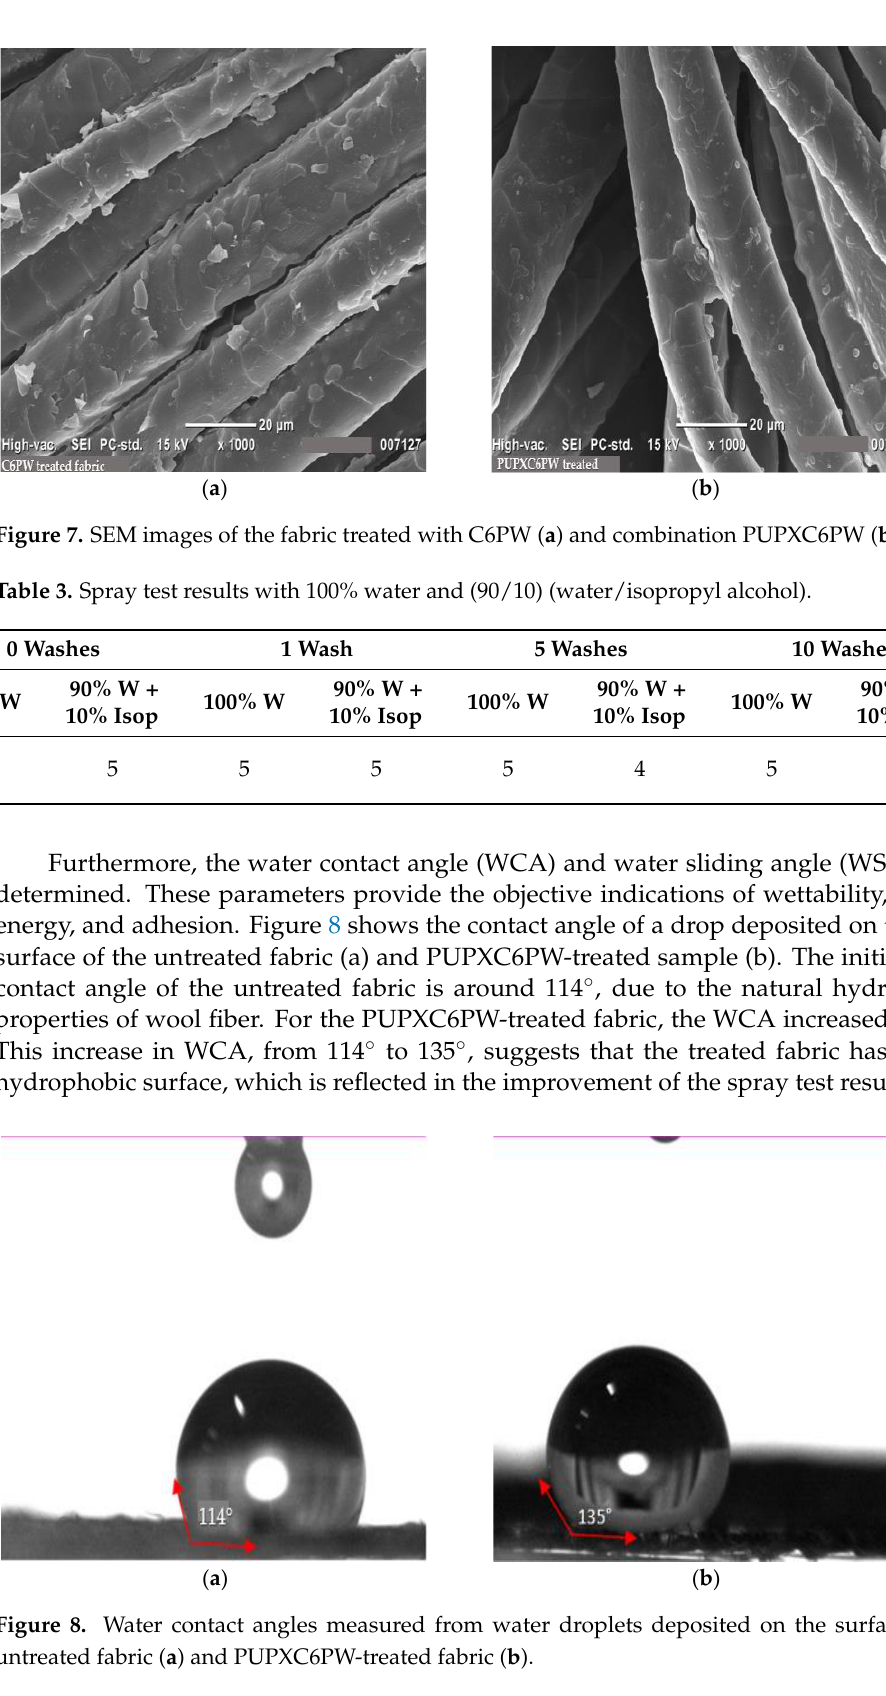
Table 4. Area shrinkage, WCA and WSA measurements of non-treated and PUPXC6PW-treated fabric. Samples